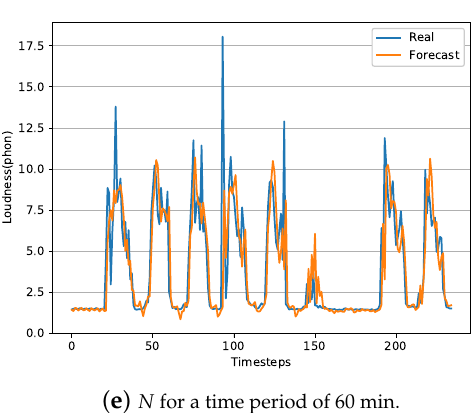
Figure 3. Representation of captured and estimated LSTM data during approximately ten days test-interval (20% of the data) of N